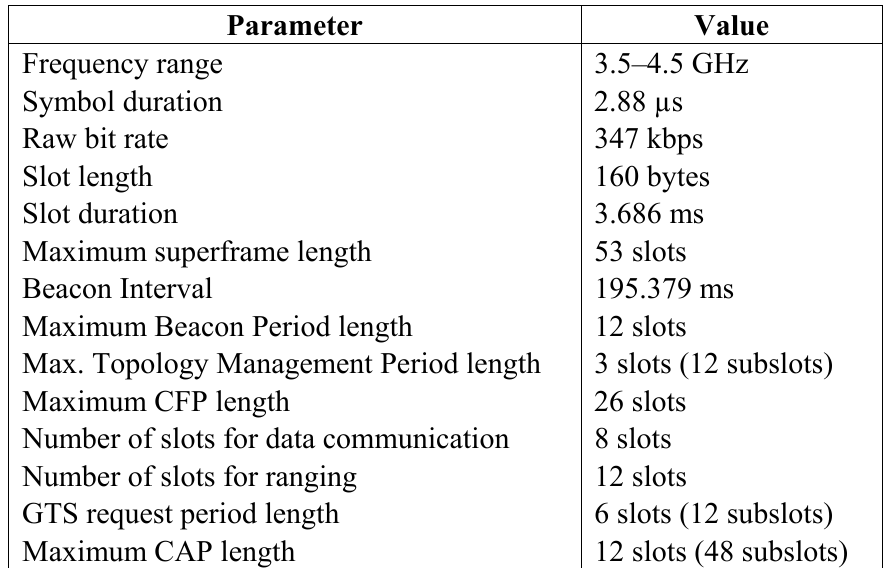
Table 1. PHY and MAC